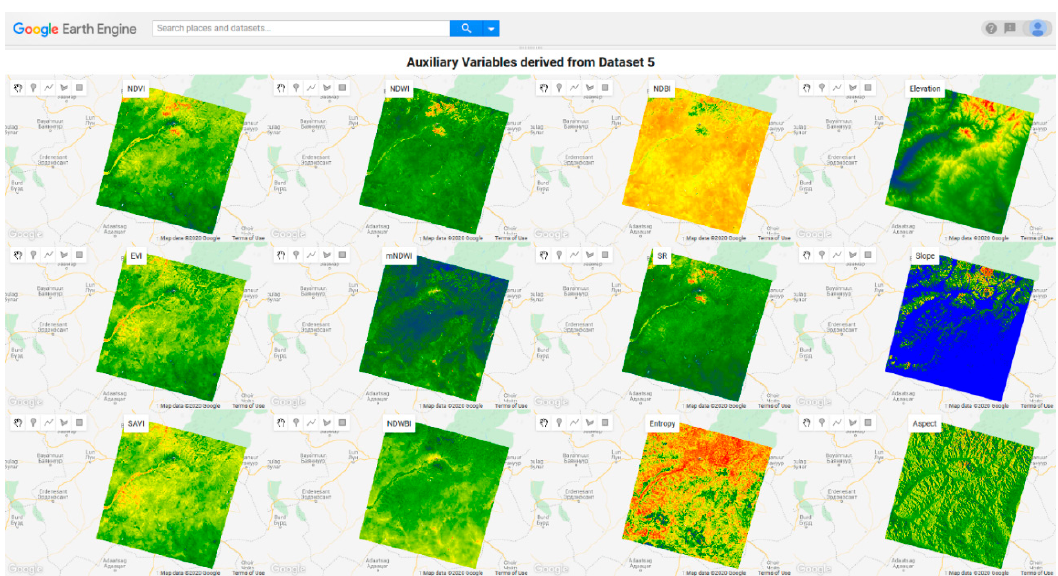
Figure A1. An example of auxiliary variables derived from Dataset 5. Color from blue to red presents the value from low to high of auxiliary variables.